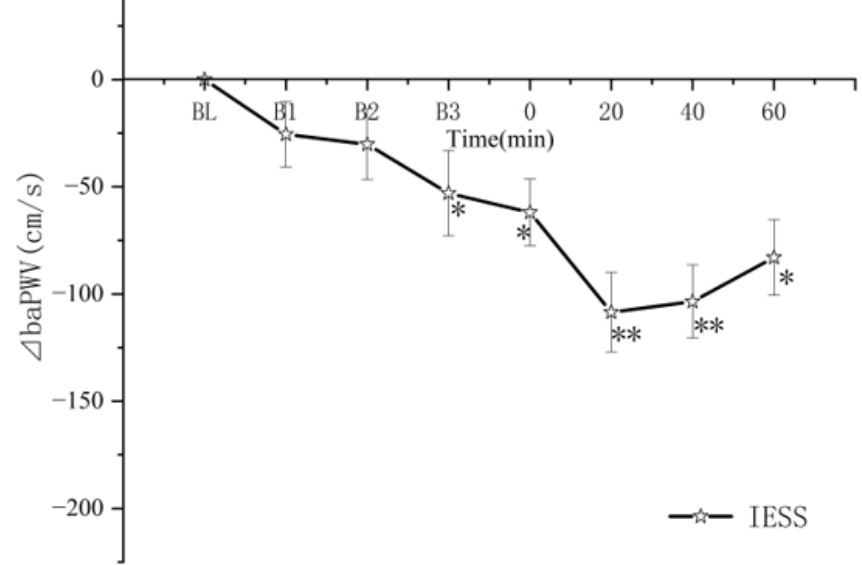
SD) Figure 4. Mean ( ± Figure 1. new Figure 4.